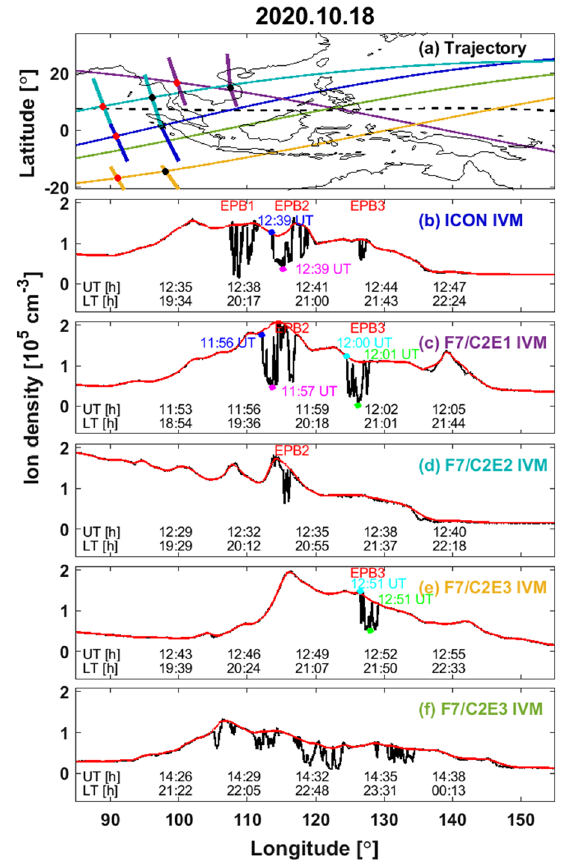
Fig. 7 The evolution of equatorial plasma bubbles measured by ICON and F7/C2 IVM around Taiwan on 18 October 2020. a Shows the ICON and F7/C2 orbits while the magnetic equator is shown with by black dashed line. The red and black points denote E‑ and F‑region sunset terminator locations corresponding to the respective orbits, where the line segments through these points indicate the alignment of the terminator. The black and red curves indicate the measured ion density and calculated background density from b ICON IVM, c F7/C2E1 IVM, d F7/C2E2 IVM e F7/C2E3 IVM (~ 2100 LT), and f F7/C2E3 (~ 2200 LT), respectively. The blue, magenta and cyan dots indicate the west and east edges of EPB2 and the west edge of EPB3,